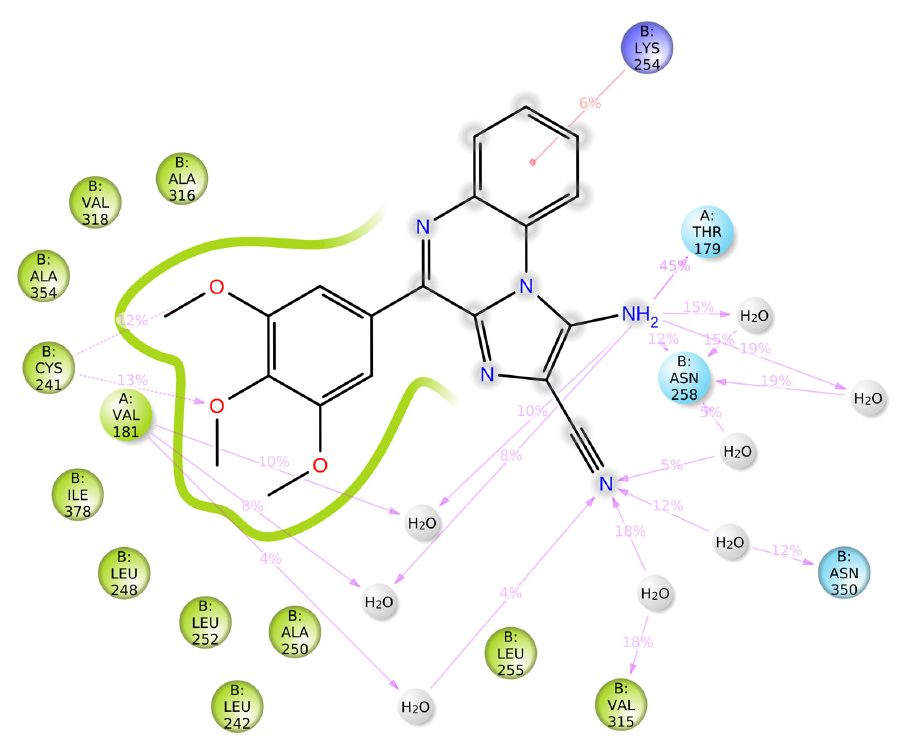
Figure 4. Time frame analysis of 1A2 with colchicine-binding domain of tubulin (PDB: 1SA0) over a simulation period of 30 ns.